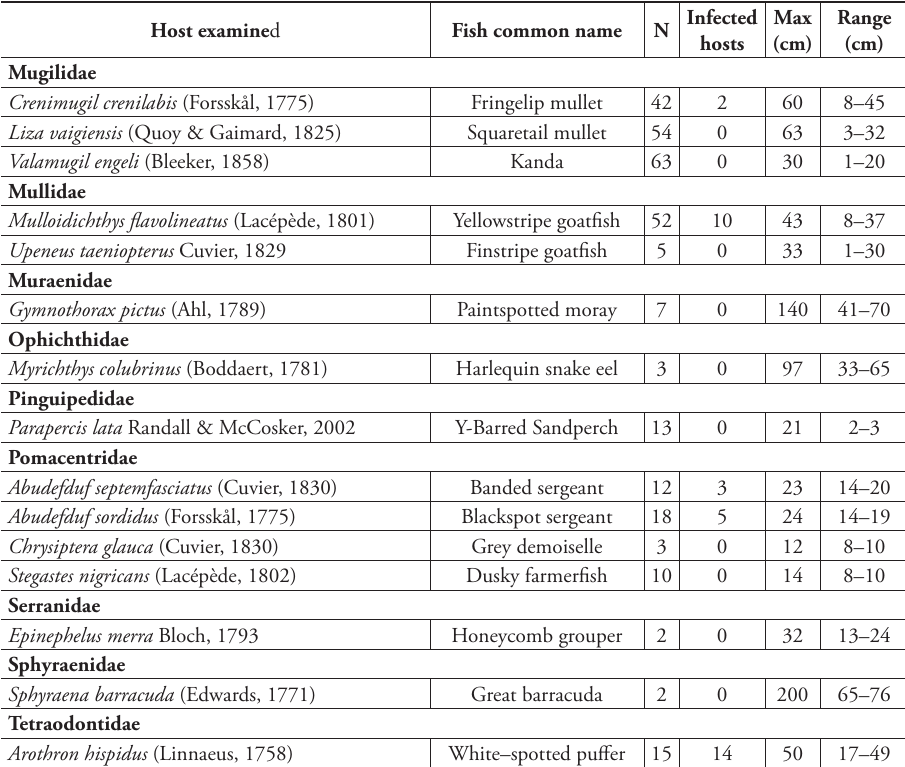
Stegastes nigricans (Lacépède, 1802)